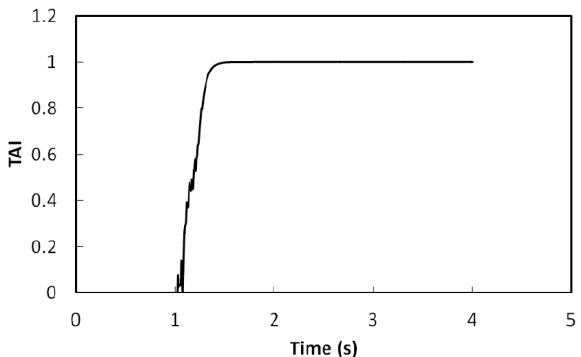
Figure 9. The TAI.